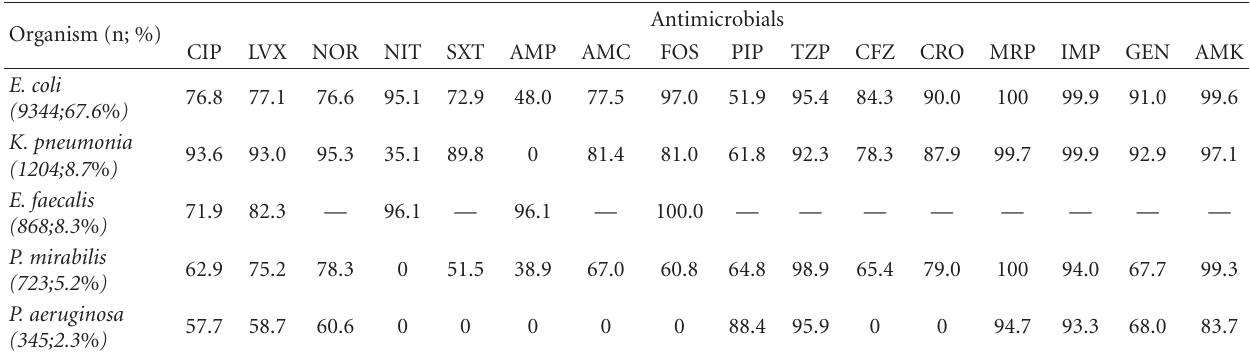
Table 4: Susceptibility rates to oral and parenteral antimicrobials of most common uropathogens isolated from urine samples. Organism (n;